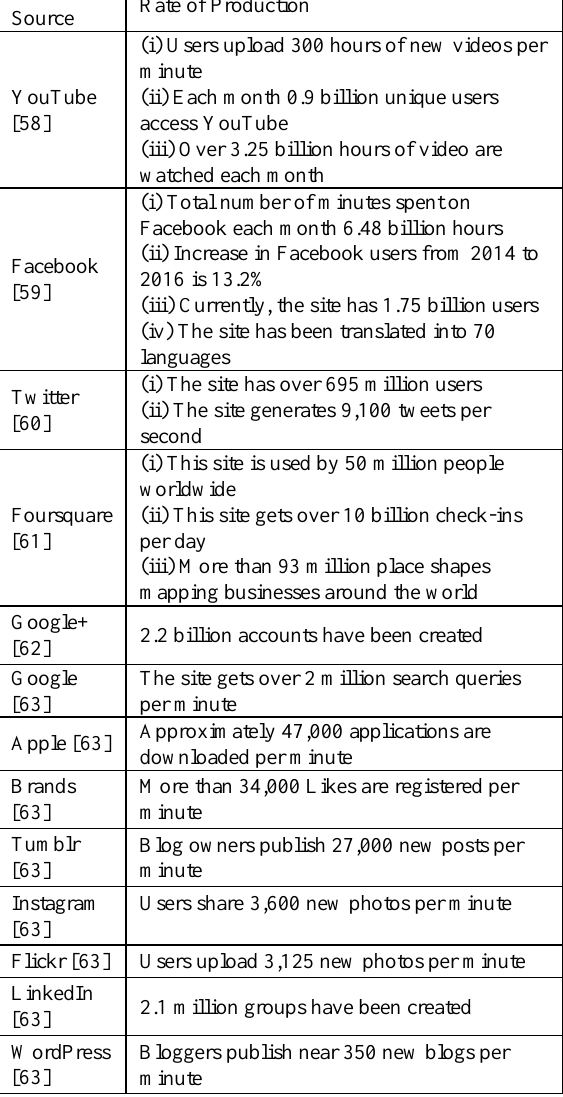
Table 1: Rapid growth of unstructured data [54] Data